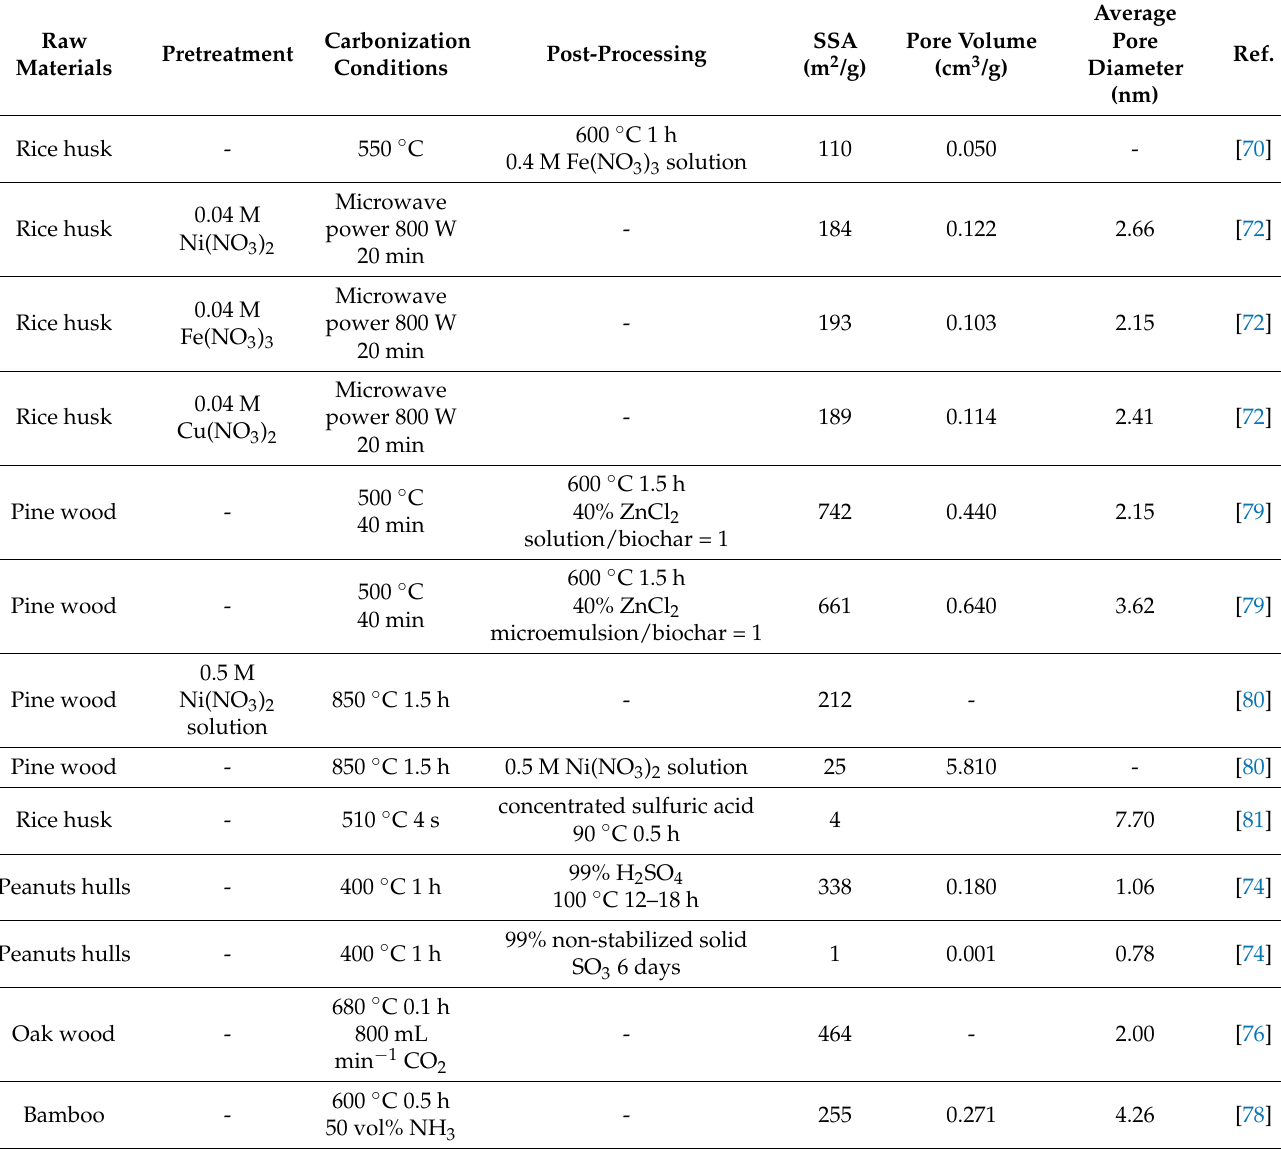
Table 2. Pore structure parameters of modified biochar prepared from LB by different modifica- tion